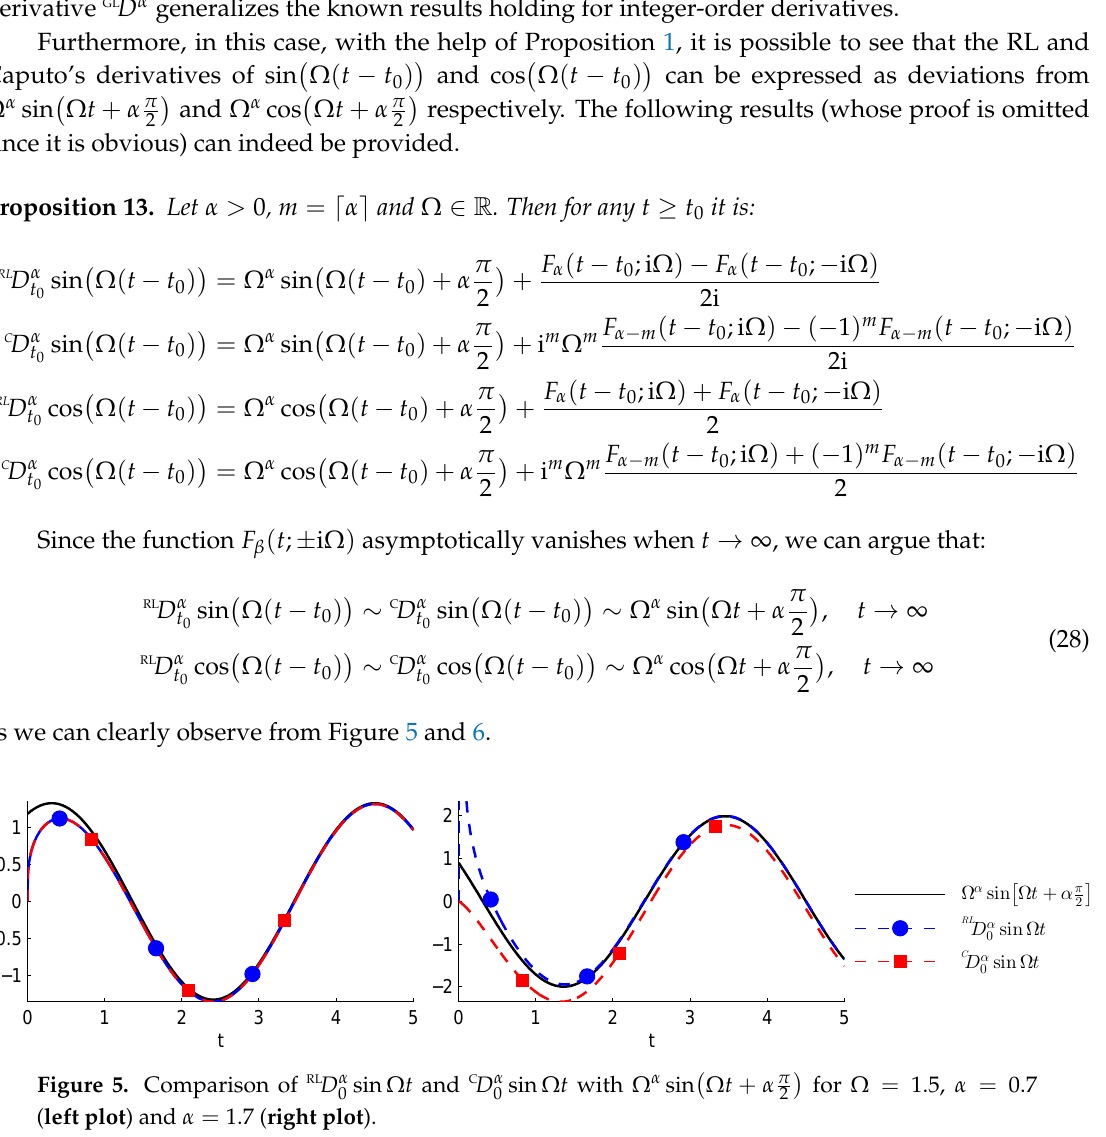
sin Ω t and C D α 0